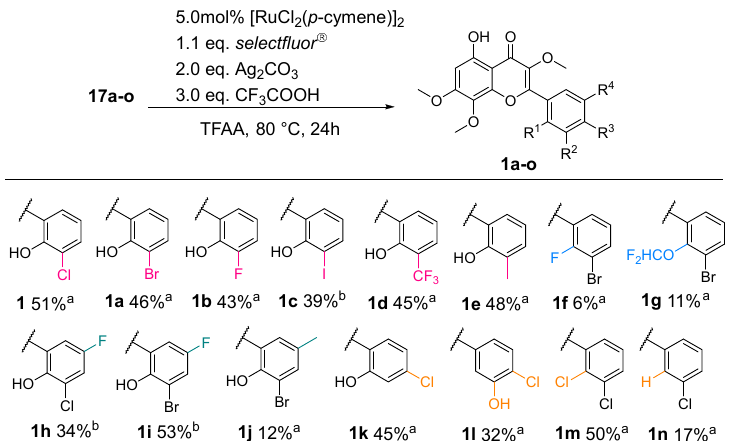
Scheme 4. Scope of ortho-C(sp 2 )-H-hydroxylation. a Reactions were performed on a 1.0 mmole scale. b 0.3–0.8 mmole reaction scales.